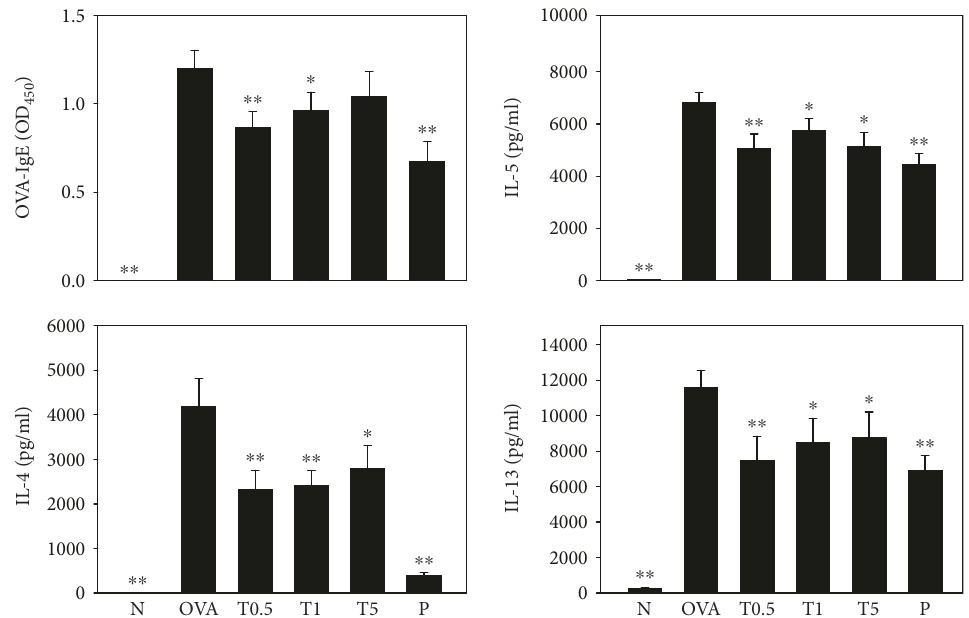
Figure 6: Tomatidine a ff ected the levels of OVA-IgE in serum and IL-4, IL-5, and IL-13 in splenocyte culture supernatant. All data are presented as means ± SEM. ∗ P < 0 05 , ∗∗ P < 0 01 compared to the OVA control group.